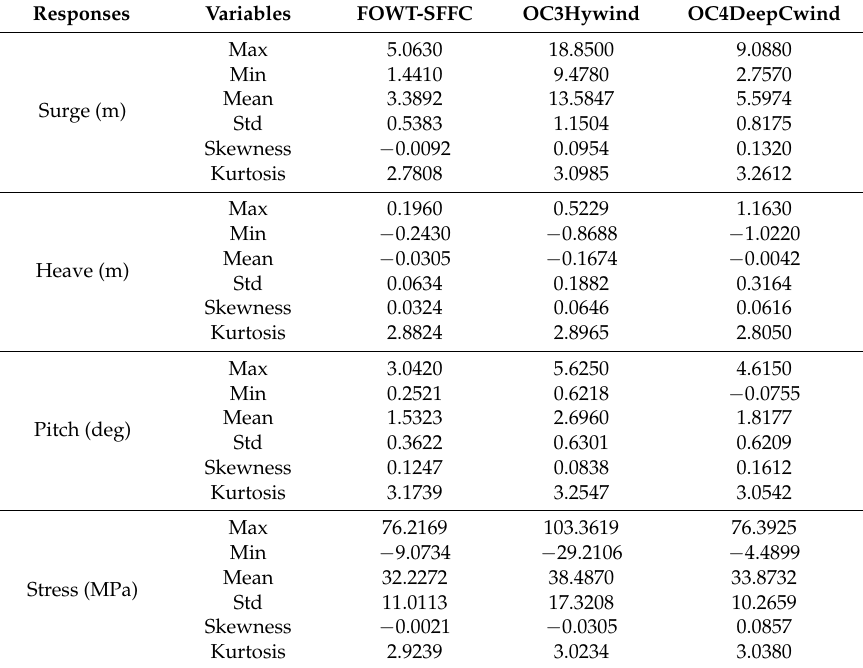
Table 9. Statistics of foundation motions and tower base stress under LC2.